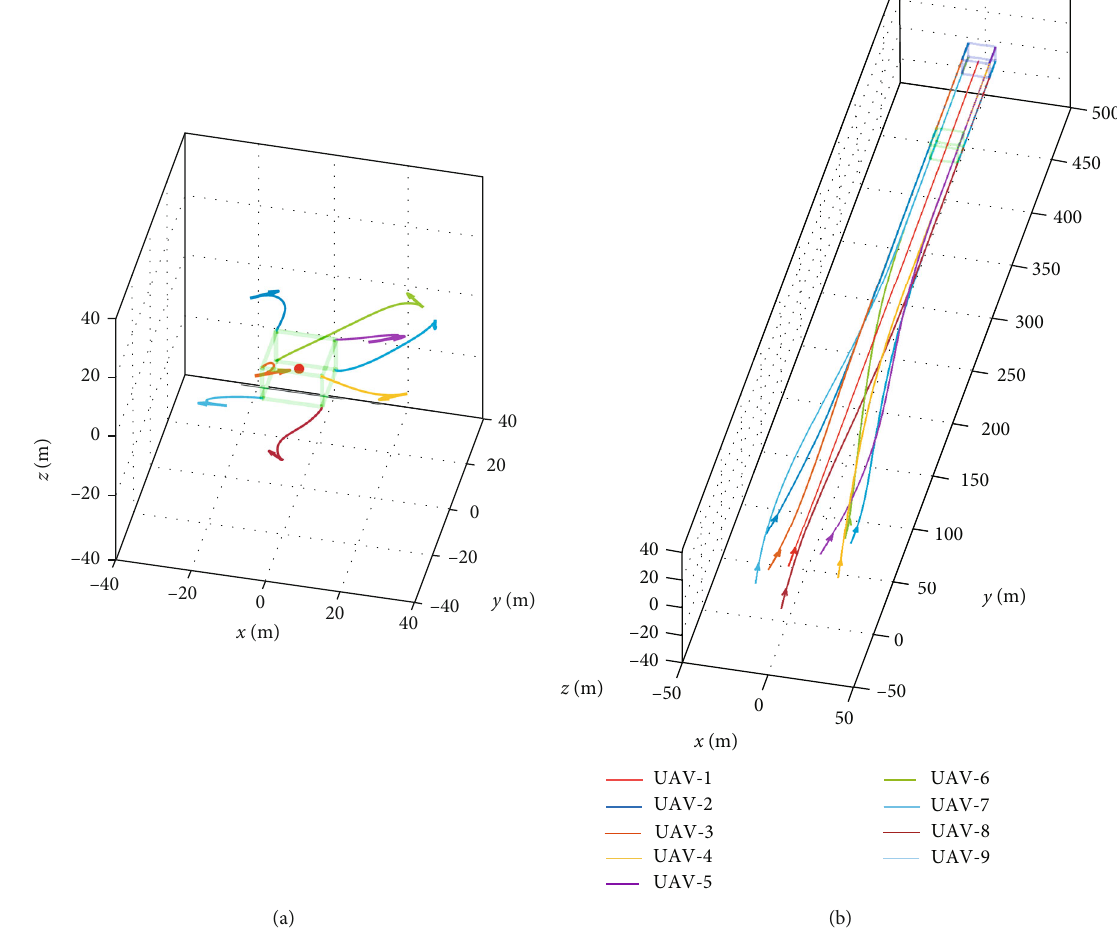
Figure 3: The trajectories in the (a) relative and (b) ground coordinates system of UAVs during rendezvous in Case 2. The arrows illustrate the initial velocities error _ e in (a) and illustrate initial velocities v in (b). The green and blue cubes depict the expected formation at the ij ,0 j ,0 prescribed time and the terminal time, respectively. Note: the arrows in (a) are lengthened three times for clear visualization and the length of arrows in (b) equals to the